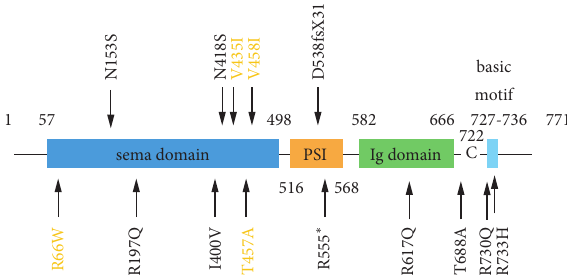
Figure 3: Schematic representation of the SEMA3A protein. Lo- cation of the SEMA3A variants characterized in IHH. Four variants caused impaired secretion of SEMA3A highlighted in